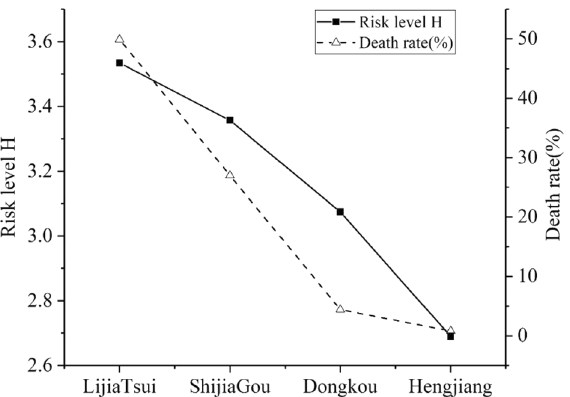
Figure 3. Comparison of life-loss risk levels and death rates, this figure is created by Microsoft Office 2013 (https:// www. micro softs tore. com. cn/ softw are/